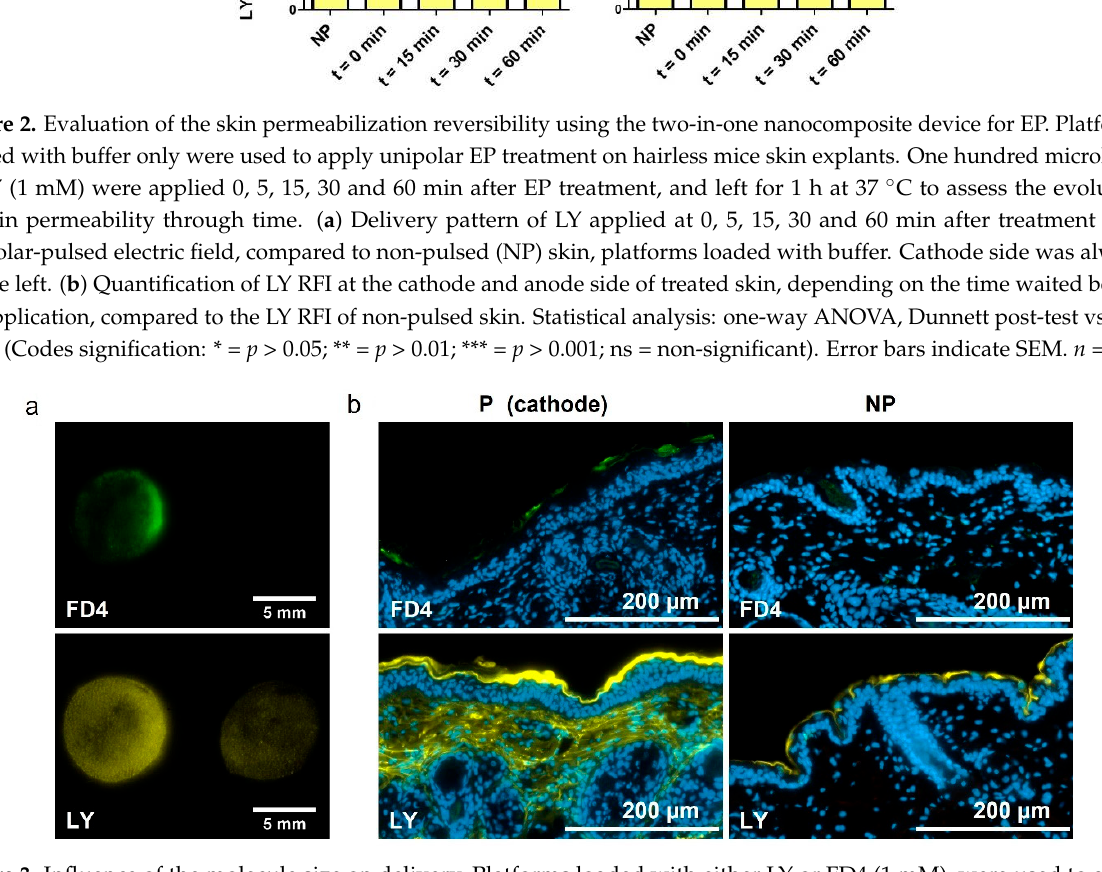
Figure 3. Influence of the molecule size on delivery. Platforms loaded with either LY or FD4 (1 mM), were used to apply unipolar EP treatment on hairless mice skin explants. Skins were imaged 30 min after. ( a ) Marking pattern of skins treated with unipolar-pulsed electric field, platforms loaded with either FD4 or LY. Cathode side is always on the left. ( b ) Histological observations of 10 µm slices of skins pulsed (P) with EP treatment or non-pulsed (NP), using platforms loaded with either FD4 or LY. FD4 is in green, LY in yellow, and nuclei are labelled in blue by DAPI.